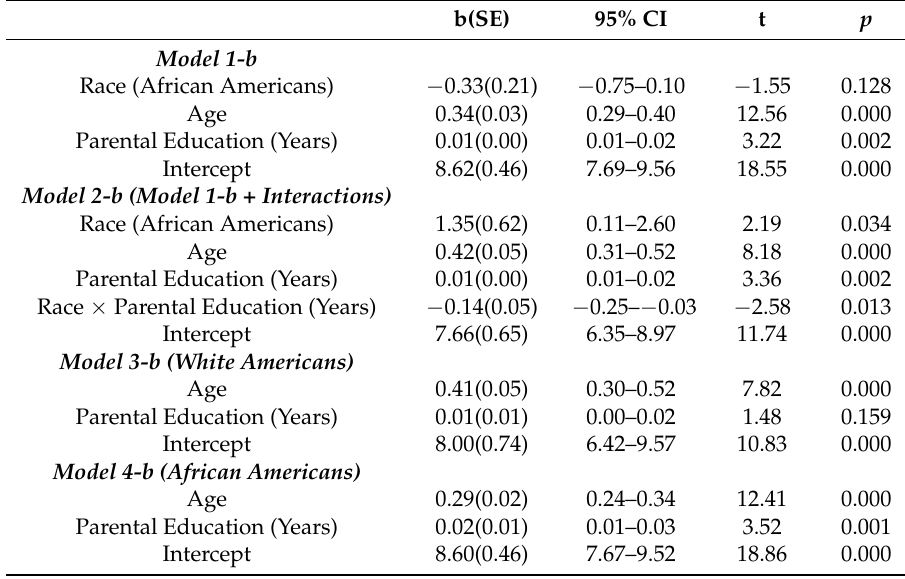
Table 4. Linear regressions between race, parental education attainment, and upward educational mobility in